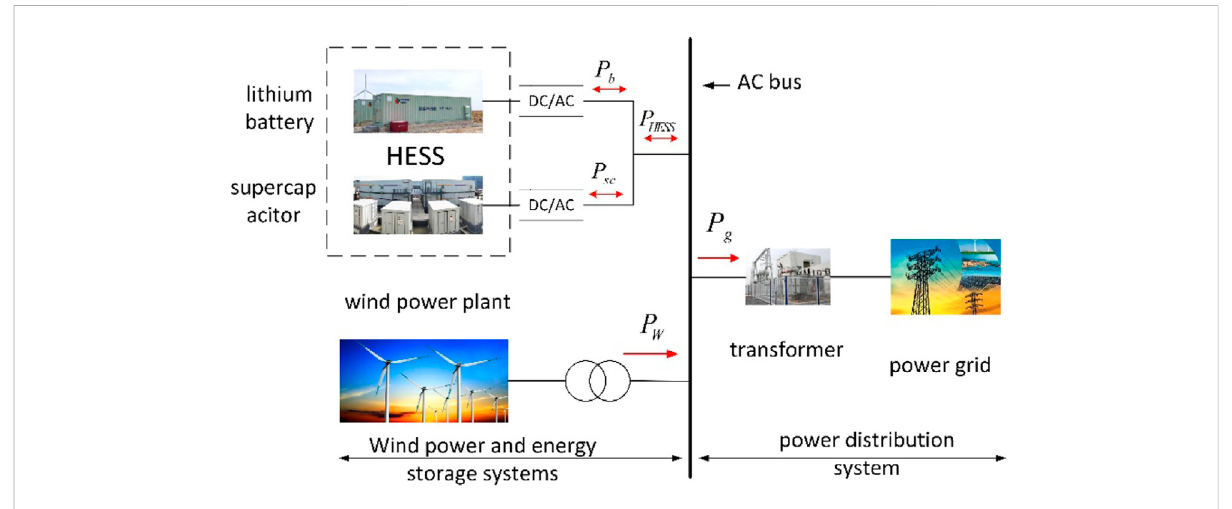
FIGURE 1 Structure diagram of the wind storage power generation